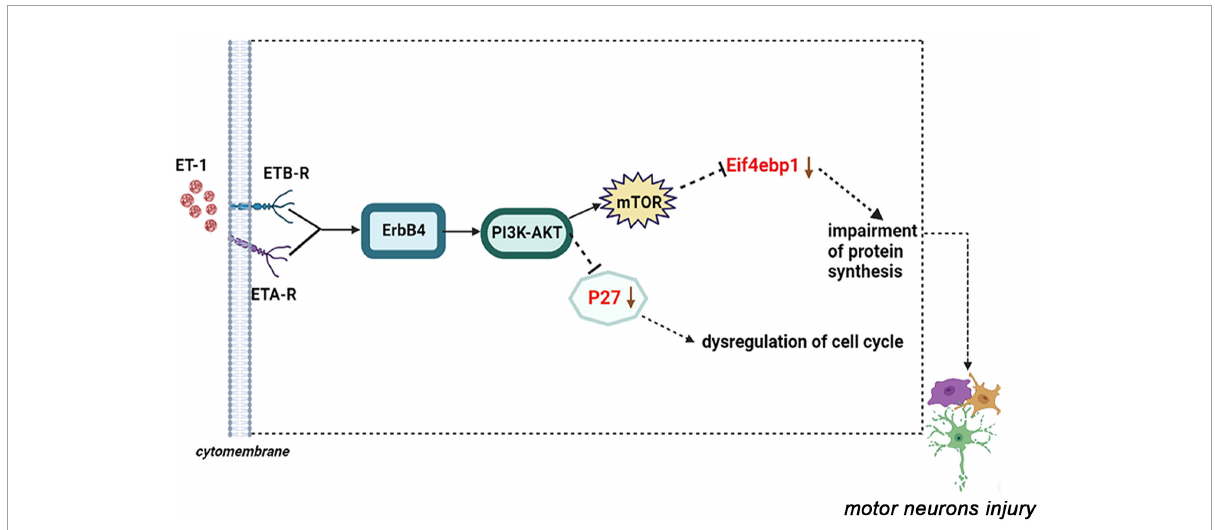
FIGURE10 A proposed model of ET-1/ET-Rs axis interacts with the downstream molecular-P27 or Eif4ebp1 and the dysfunction of these genes may result in motor neurons injury (ErbB signaling pathway: pathway ID#